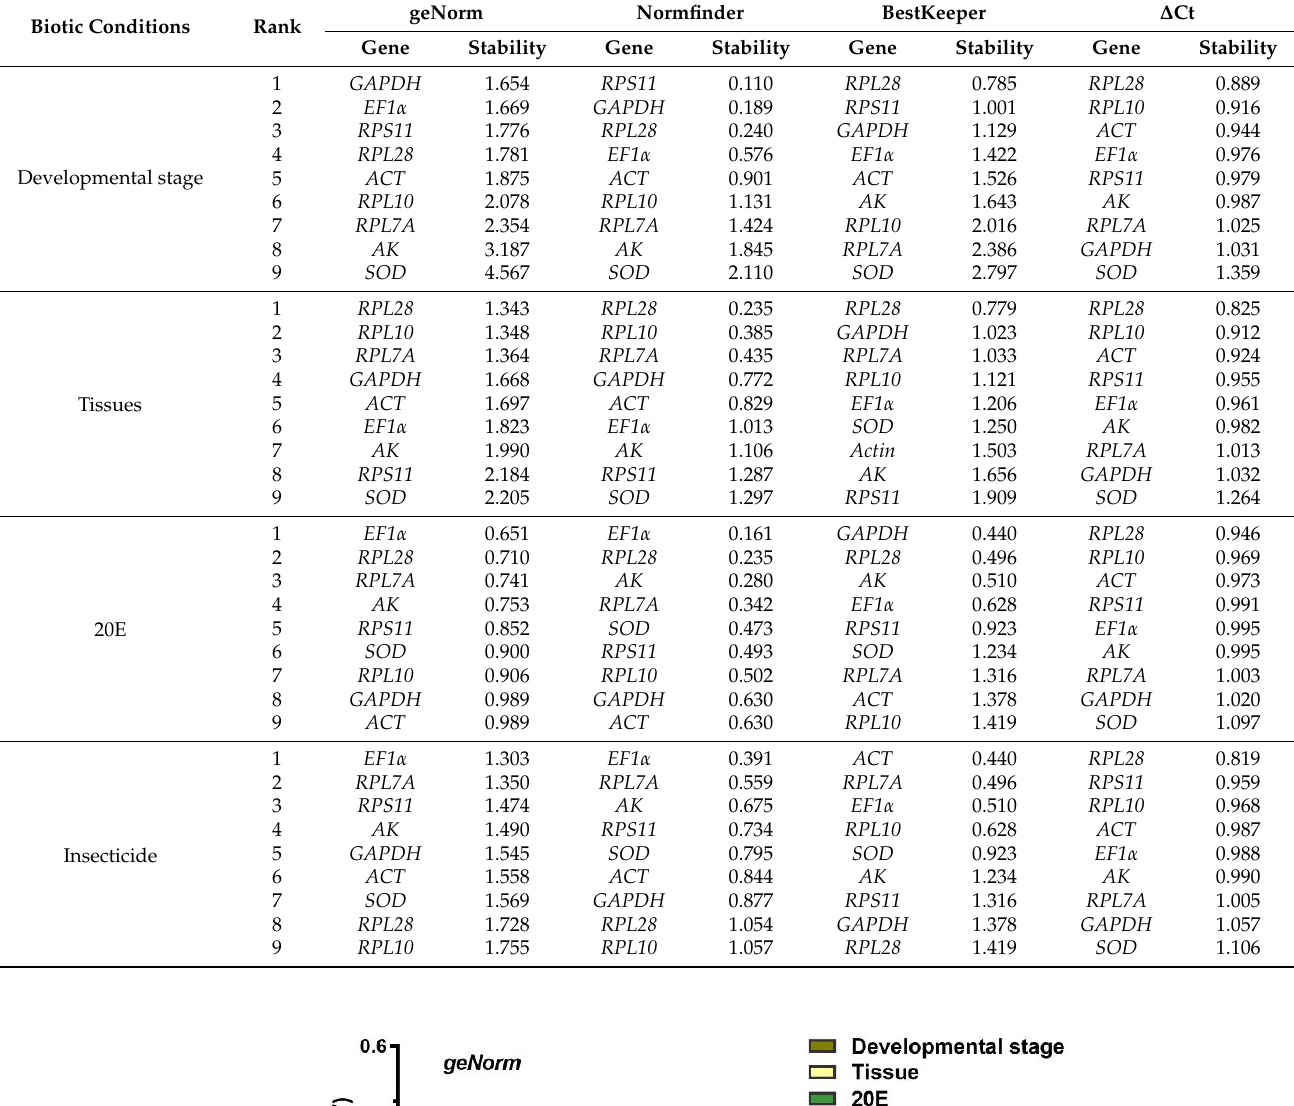
Table 3. Ranking of the T. absoluta reference genes under four experimental conditions.